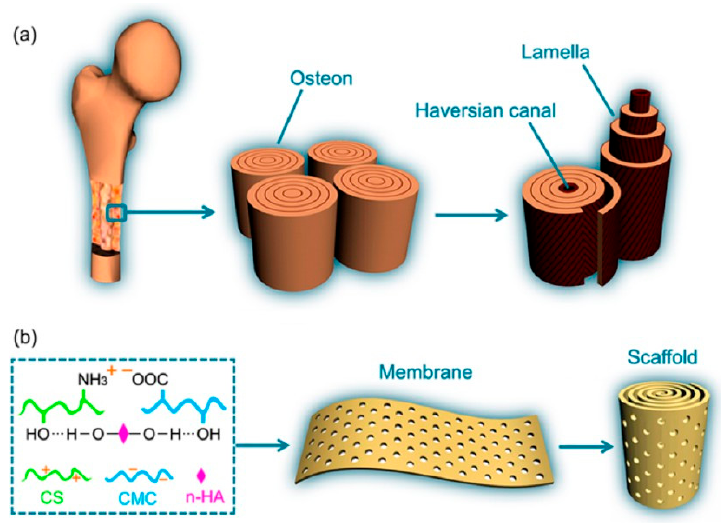
Figure 9 . Structural comparison between natural bone ( a ) and the CS/NaCMC/n-HA spiral-cylindrical Figure 9. Structural comparison between natural bone ( a ) and the CS / NaCMC / n-HA spiral-cylindrical scaffold ( b ) (reproduced with permission from Ref. [93]). sca ff old ( b ) (reproduced with permission from Ref.